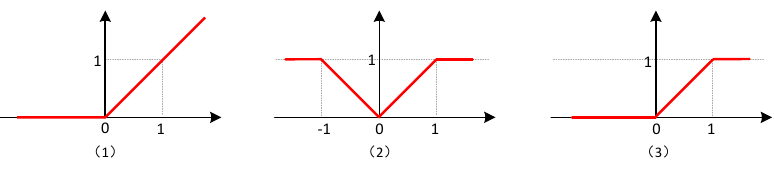
Figure 3. Three activation